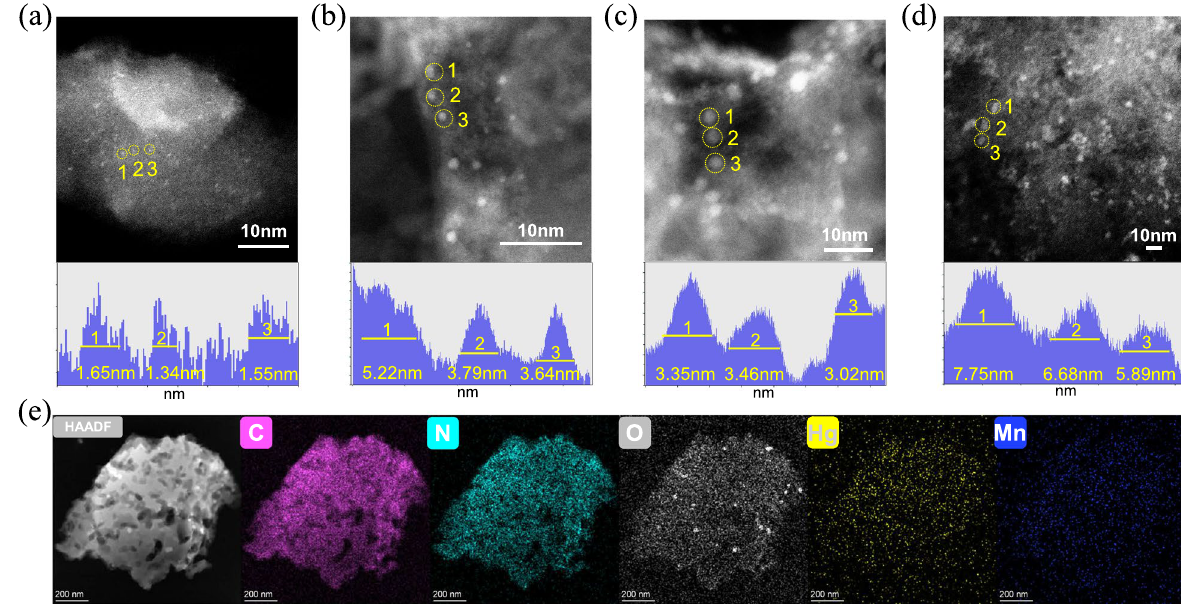
Fig. 1 AC-HAADF-STEM images and the corresponding intensity profiles of ( a ) Mn δ -N 2 O 2 /BC shrimp , ( b ) Mn δ -N 2 O 2 /BC crab , ( c ) Mn δ -N 2 O 2 /BC peanut , ( d ) Mn δ -N 2 O 2 /BC sludge , ( e ) Elemental mappings of C, N, O, Hg, and Mn of Mn δ -N 2 O 2 /BC shrimp after Hg 0